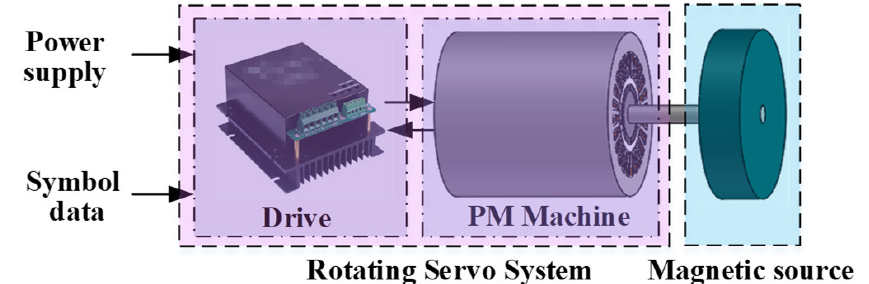
Figure 1. Typical RMBMA architecture.